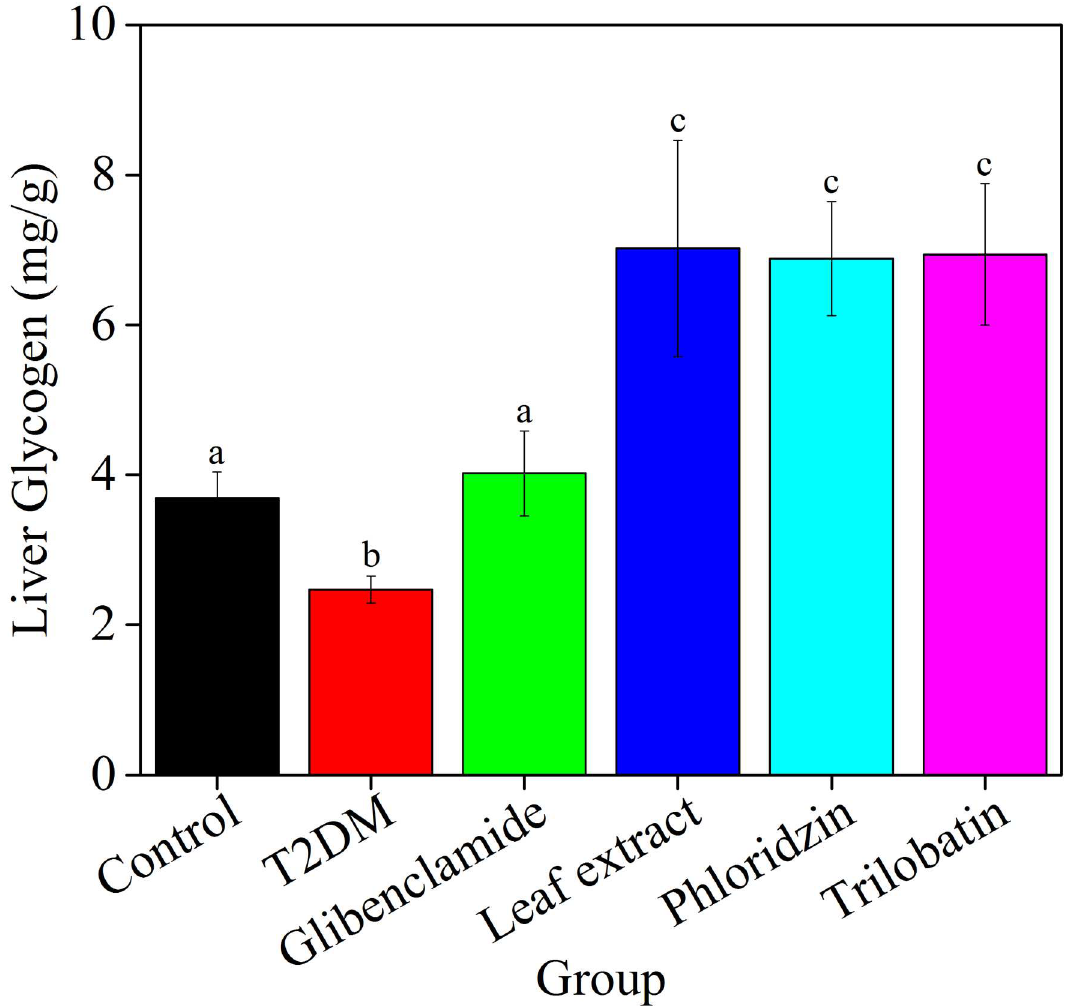
Fig 4. Leaf extractsfrom L . polystachyus Rehd. significantly increaseliver glycogen of experimental T2DM mice four weeks post gavage. After 12 h fast, liver sampleswere immediately separated, dippedinto liquid nitrogenand stored in -80˚C prior to measure liver glycogen.The data were analyzedwith ANOVA. All the values are expressedas the mean ± SEM, n = 10. Columns labeledwith different letters are significantly different at P <